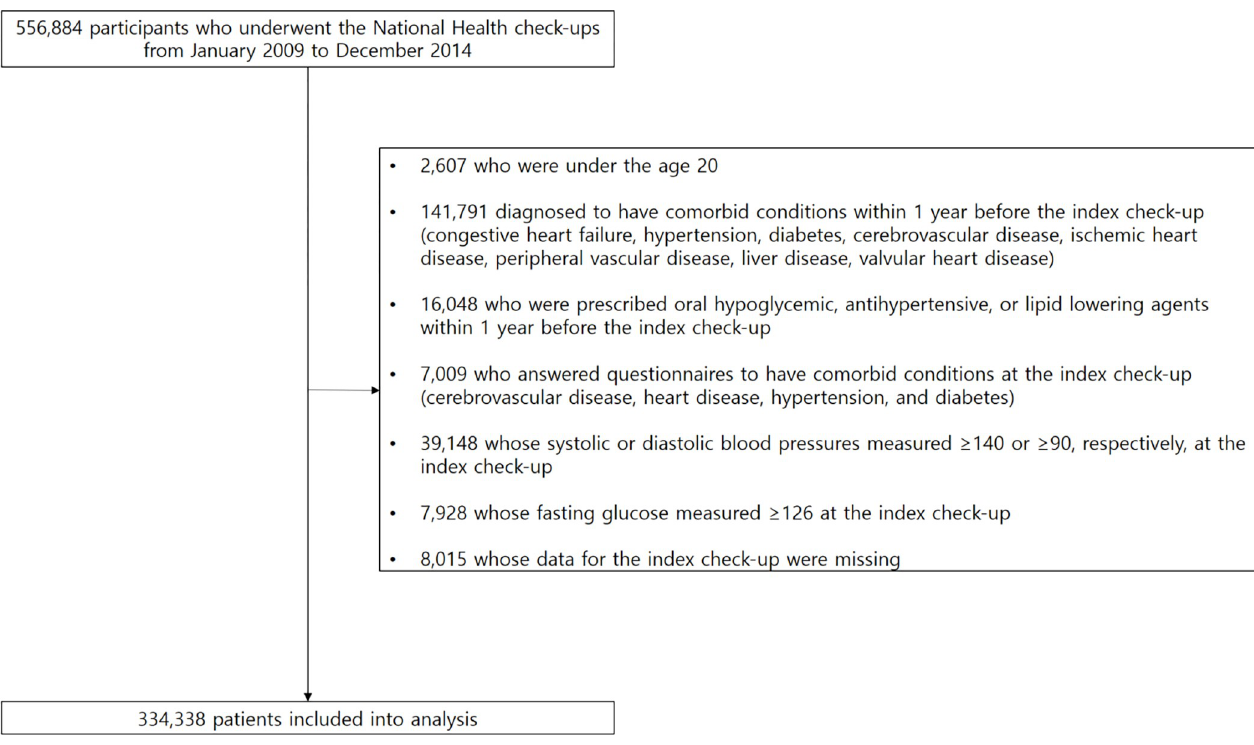
Fig 1. Overview of the study